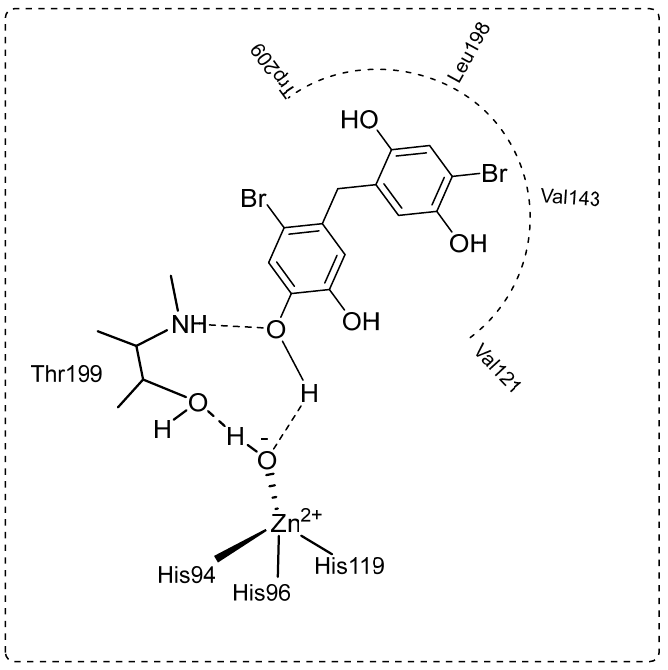
Figure 3. The proposed binding mechanism between the CA II isoenzyme and 4-bromo-5-(4-bromo- 2,5-dihydroxybenzyl)benzene-1,2-diol ( 20 ) by anchoring to the zinc ion (Zn 2+ ) coordinated water (H 2 O)/hydroxide ion